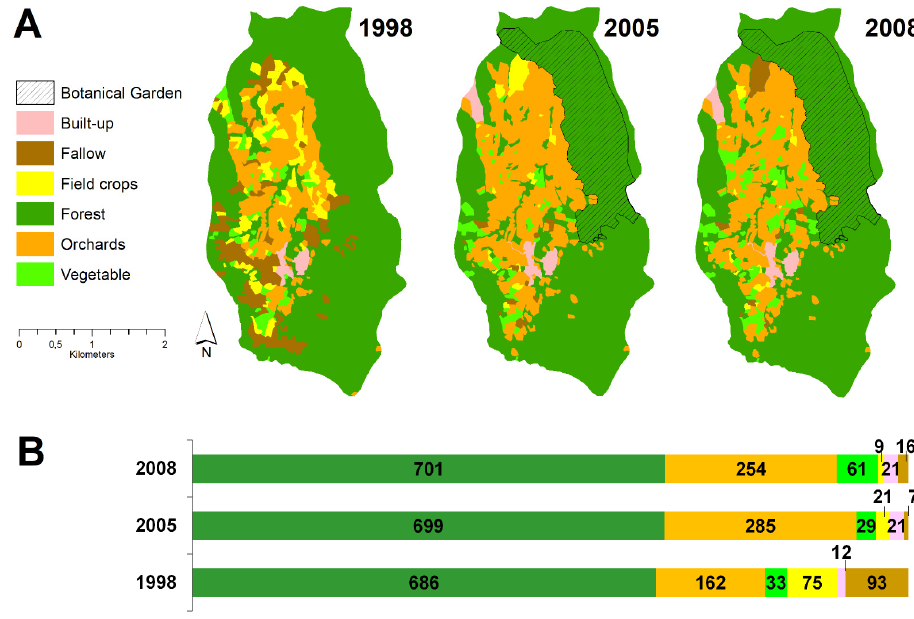
Figure 3. Spatial ( A ) and temporal ( B ) distribution (in ha) of land-use types in Mae Sa Mai watershed in 1998, 2005 and 2008.